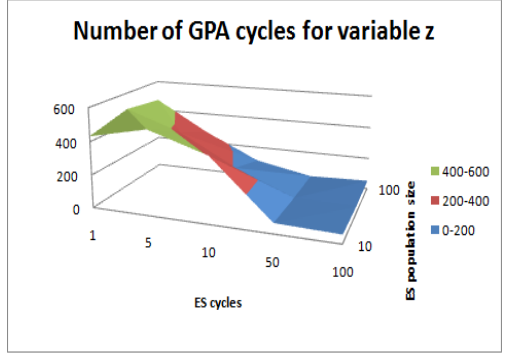
Fig. 5: Number of iterations of encapsulating GPA for z variable depending on ES cycle limit and ES population